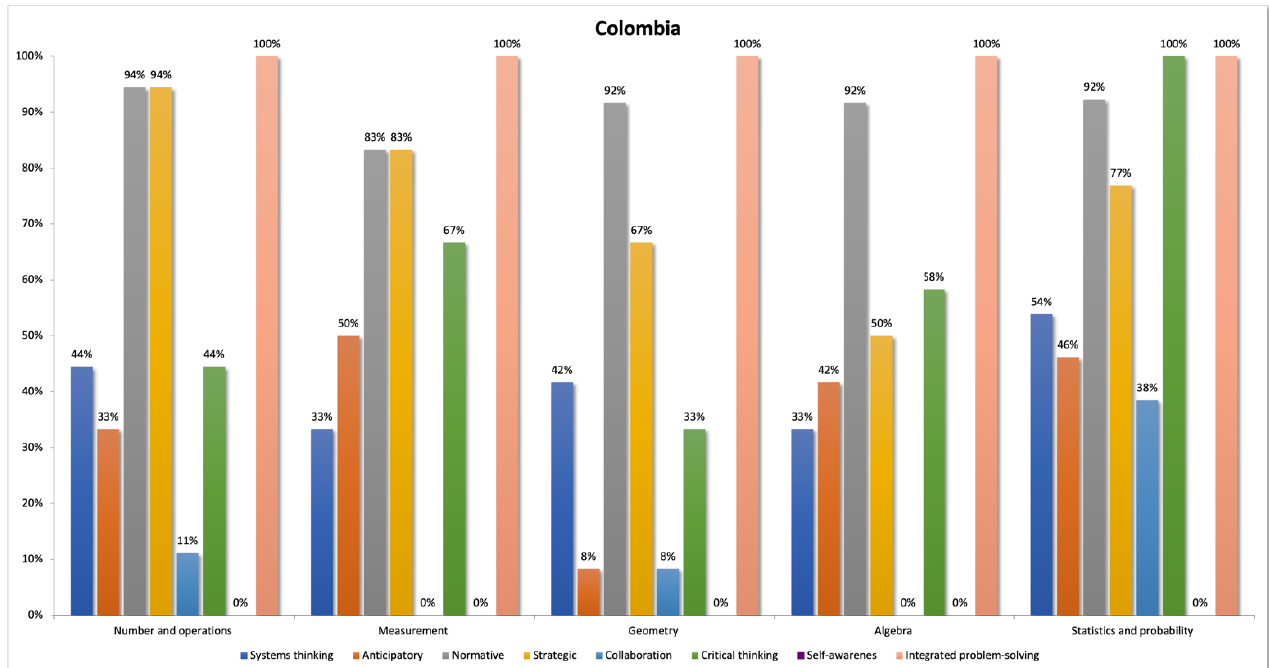
Figure 2. Sustainability competence distribution in Colombia according to thematic axis.